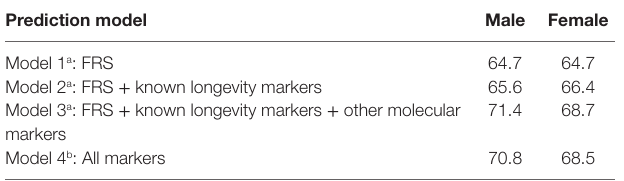
TaBle 3 | Predictive value (aUc) based on validation sets of various prediction